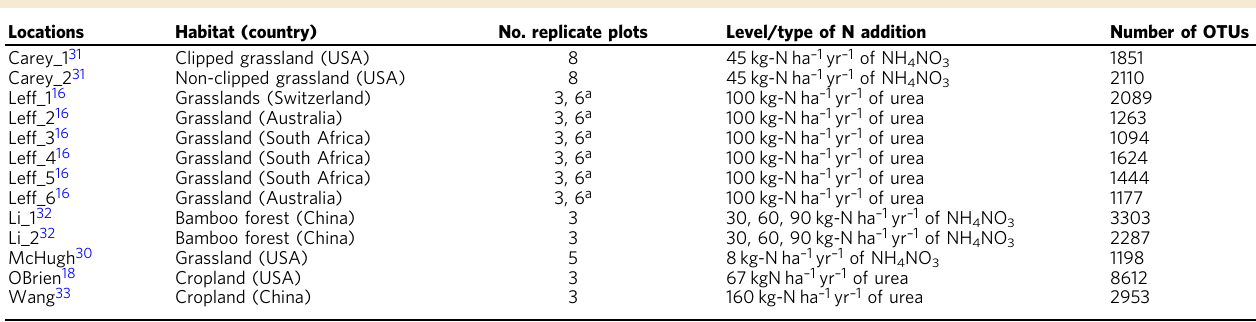
Table 1 Characteristics of study